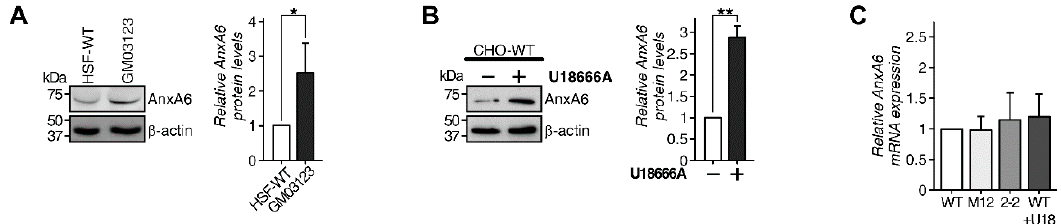
Figure 1. Elevated AnxA6 protein levels in NPC1 mutant cells. Cell lysates from ( A ) human control (HSF) and NPC1 patient (GM03123) skin fibroblasts and ( B ) CHO-WT treated for 16 h with and without U18666A (2 μ g/mL) as indicated were analyzed by Western blotting with antibodies against AnxA6 and β -actin as loading control. Western blots representative for three independent experiments are shown (* p < 0.05, ** p < 0.01). ( C ) Relative mRNA quantification determined by qPCR of AnxA6 in CHO-WT, CHO M12, CHO 2-2, and CHO-WT cells treated with U18666A (WT + U18) is shown. The housekeeper gene Rpl13 served as control. Data shown represents the mean ± SEM from three independent experiments with duplicate samples.